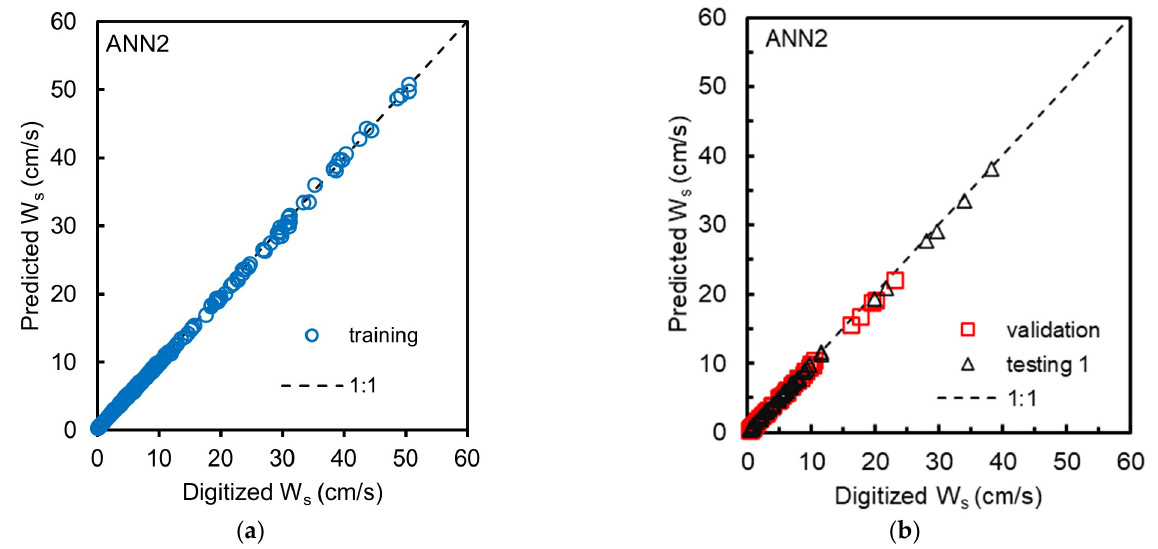
Figure 3. Scattering plot for results of training ( a ); validation and testing 1 for ANN2 ( b ).